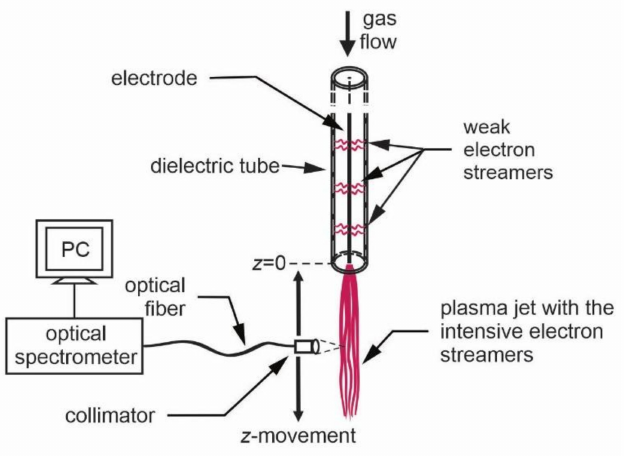
Figure 2. Schematic presentation of the axial plasma jet characterization by moving the optical